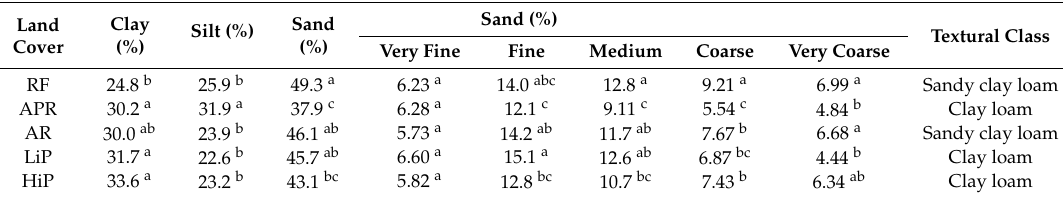
Table 2. Mean values for soil particle size distribution, and textural class according to the USDA classification of the depth 0–5 cm for each land use type. For each variable, different superscript letters denote statistically significant differences between land use types, according to the Tukey’s test ( p < 0.05). RF, Reference Forest; APR, Assisted Passive Restoration; AR, Active Restoration; LiP, Low-intensity Pasture; HiP, High-intensity